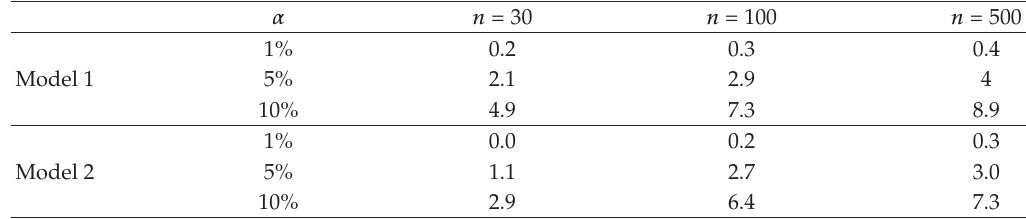
Table 1: Empirical sizes (cid:8) % (cid:9)